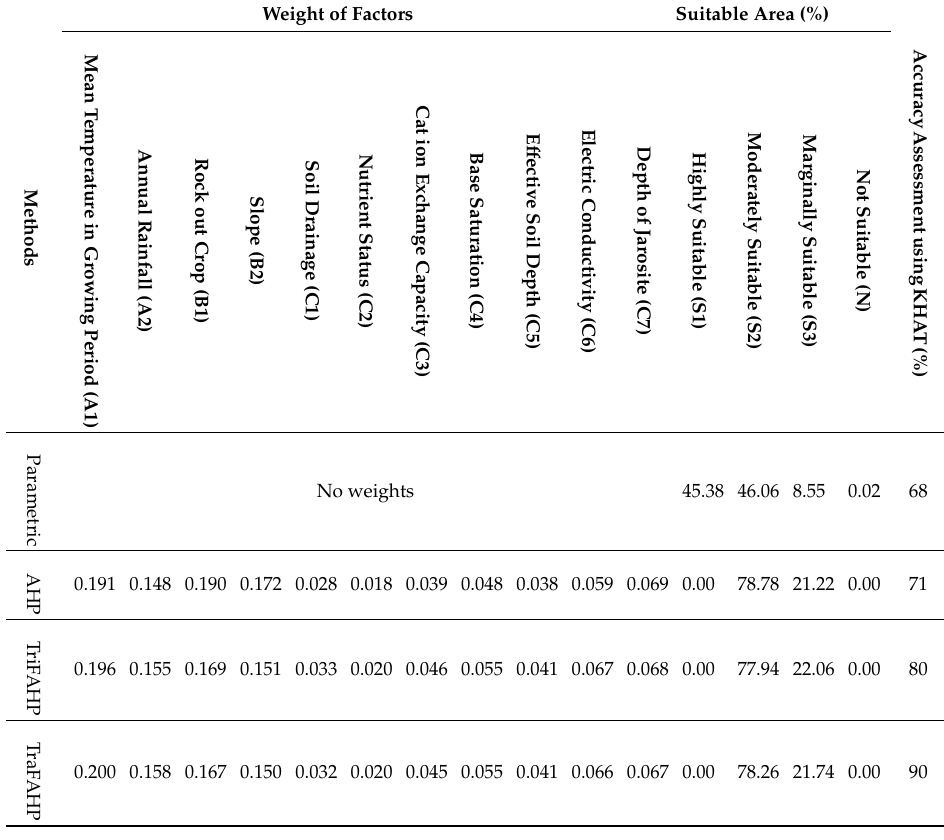
Table 12. Comparison of the results from parametric, AHP, Triangular fuzzy AHP (TriFAHP) and Trapezoidal FAHP (TraFAHP)